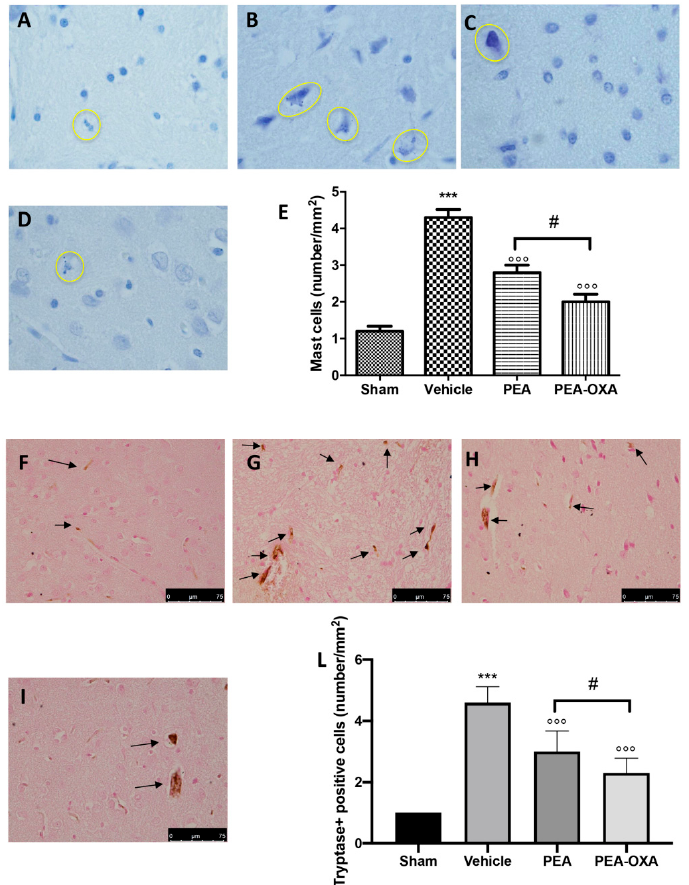
Figure 2. E ffi cacy of PEA-OXA on mast cell infiltration and degranulation induced by transient MCAo. An increased number of mast cells were detected in tissues from vehicle-treated animals ( B , E ) compared to the control ( A , E ). PEA and PEA-OXA-treated ischemic rats showed fewer cells of this type ( C – E ). An increased expression of tryptase ( G , L ) was found in sections obtained from vehicle-treated rats compared to the sham-operated animals ( F , L ). PEA-OXA administration reduced tryptase expression more effectively than did PEA ( H , I , L ). The number of mast cells was counted in three sections per animal and is presented as the number of positive cells per high-power field. For the mast cells, a 100 × magnification is shown (10- µ m scale bar). For the immunohistochemistry, a 40 × magnification is shown (75- µ m scale bar). A p -value of less than 0.05 was considered significant: *** p < 0.001 versus sham; ◦◦◦ p < 0.001 versus vehicle; # p < 0.05 versus